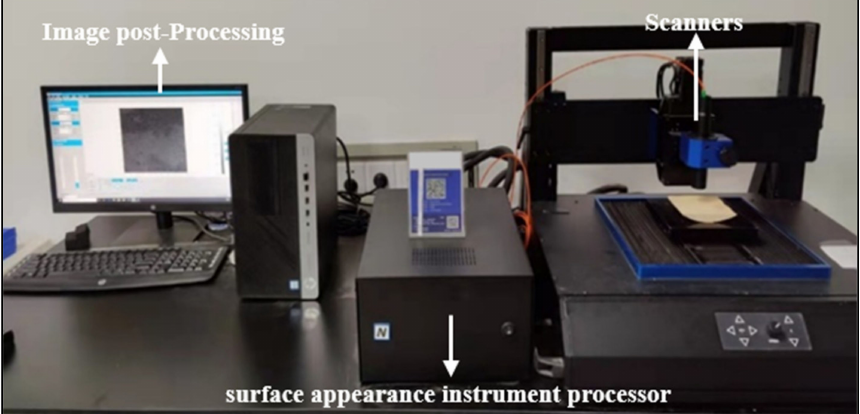
Figure 9. Three-dimensional surface appearance